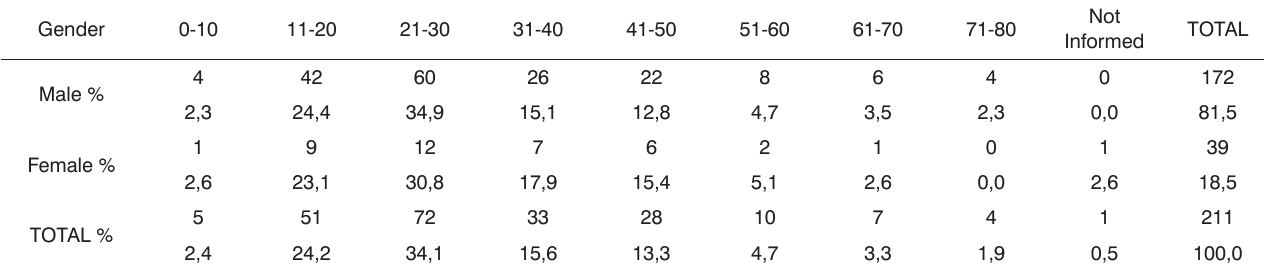
Table 1. Distribution of sample per age group and gender of patients.